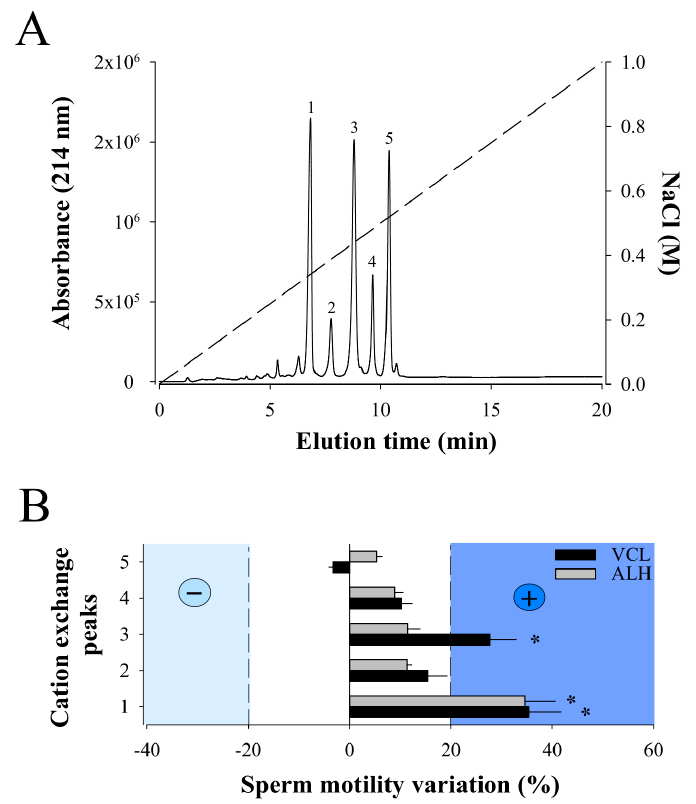
Figure 3. Bioactivity of purified F11 compounds. ( A ) Cation exchange chromatogram illustrating the purification of five compounds from F11 fraction. The dashed line illustrates the NaCl gradient used for elution of the compounds. Minor peaks (two before compound 1 and one after compound 5) were not purified. ( B) Secondary screening of the compounds purified by cation chromatography on sperm motility parameters VCL and ALH. Positive compounds were considered as those that exceeded + 20% variations for both VCL and ALH (compound 1). Data normalized to variation produced in control condition. * p <